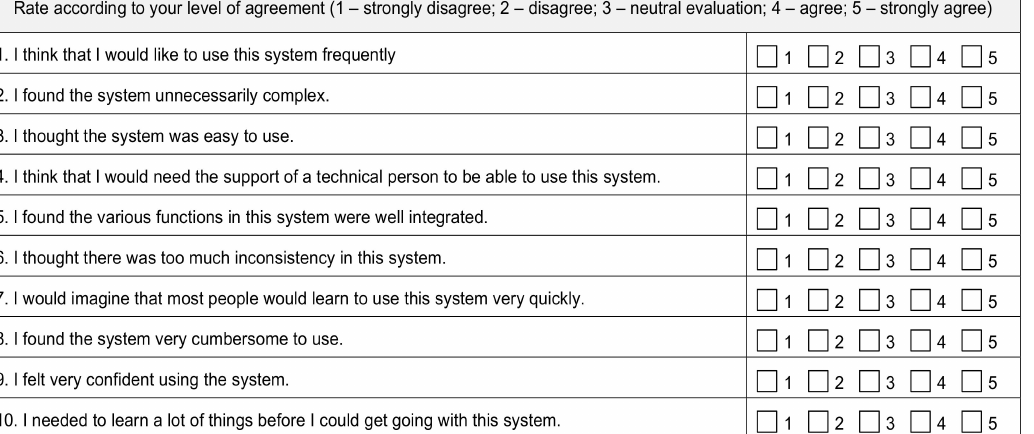
Figure 3. System Usability Survey